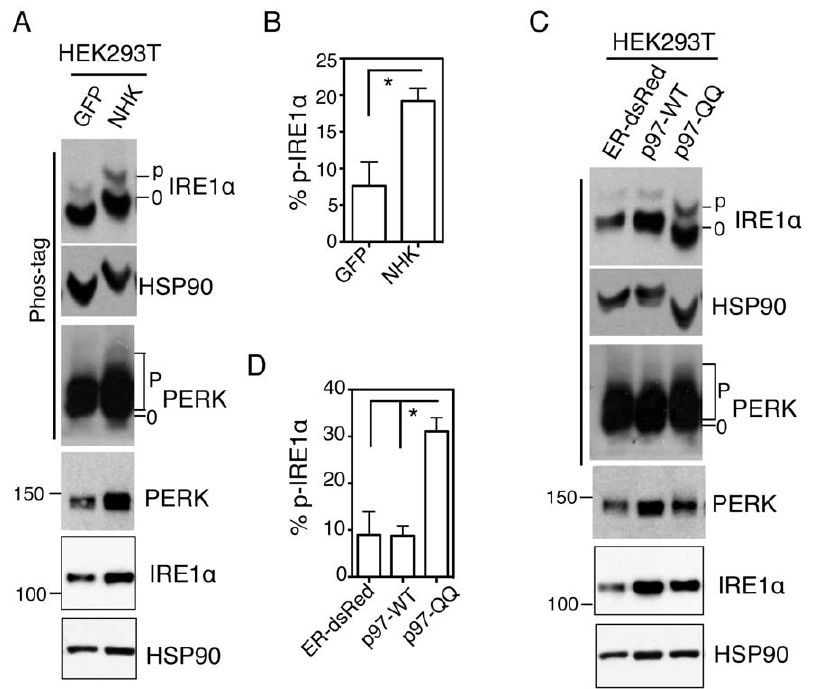
Figure 2. Accumulation of misfolded proteins induces mild ER stress. ( A and C ) Immunoblots of IRE1 a and PERK in HEK293T cells transfected with the indicated plasmids for 24 h. NHK, the unfolded form of a 1-antitrypsin; p97-QQ, dominant negative form of p97-WT. ER-dsRed and GFP, negative control plasmids. HSP90, a position and loading control. ( B and D ) Quantitation of percent of phosphorylated IRE1 a in total IRE1 a protein in Phos-tag gels shown in A , C . Values are mean 6 SEM *, P , 0.05 using unpaired two-tailed Student’s t -test. Representative data from at least three independent experiments shown.